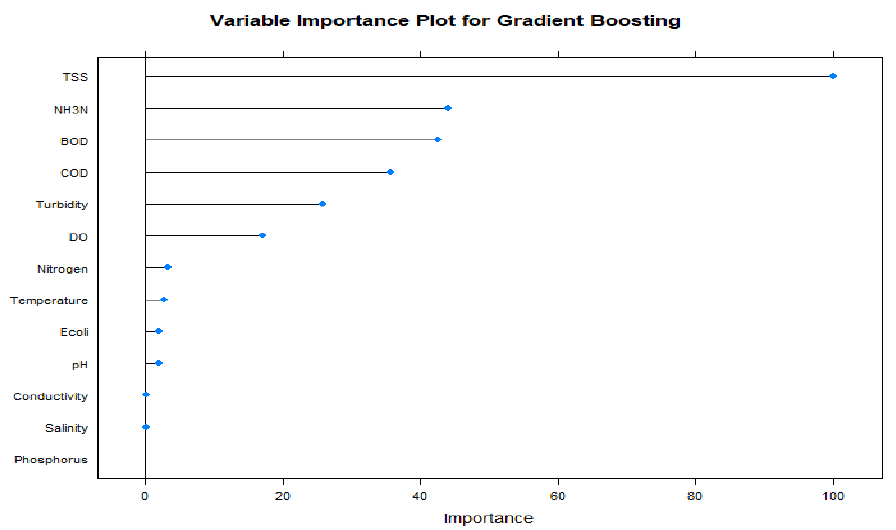
Figure 5. Predictor importance of the Gradient Boosting Model for WQC.